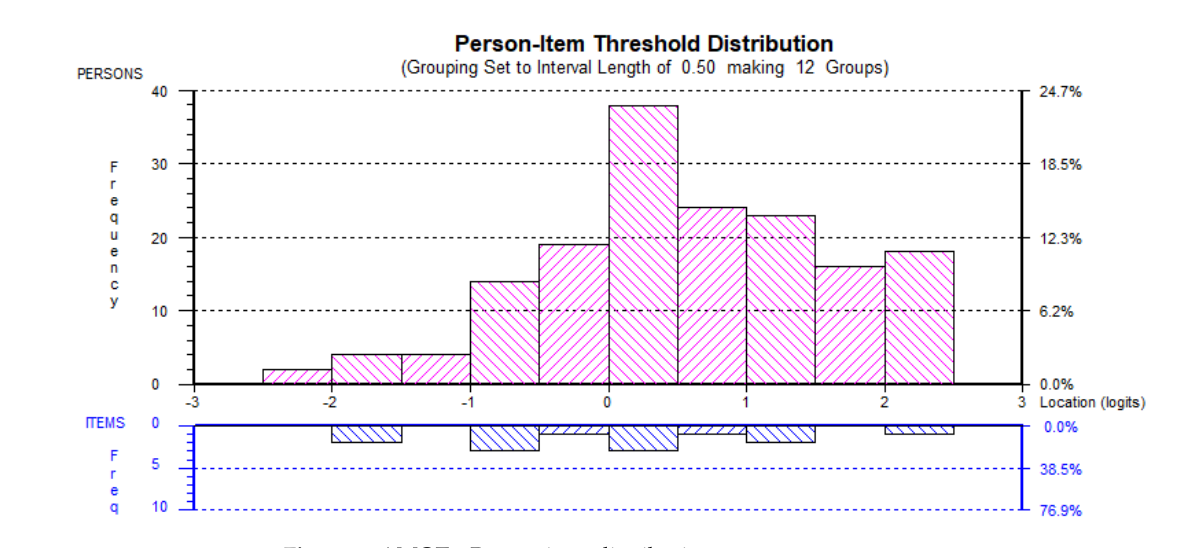
Figure 1. AMOT rs Person-item distribution.